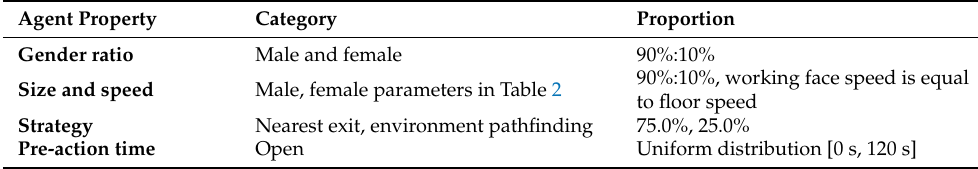
Table 7. Constructor parameters in analysis of working face’s